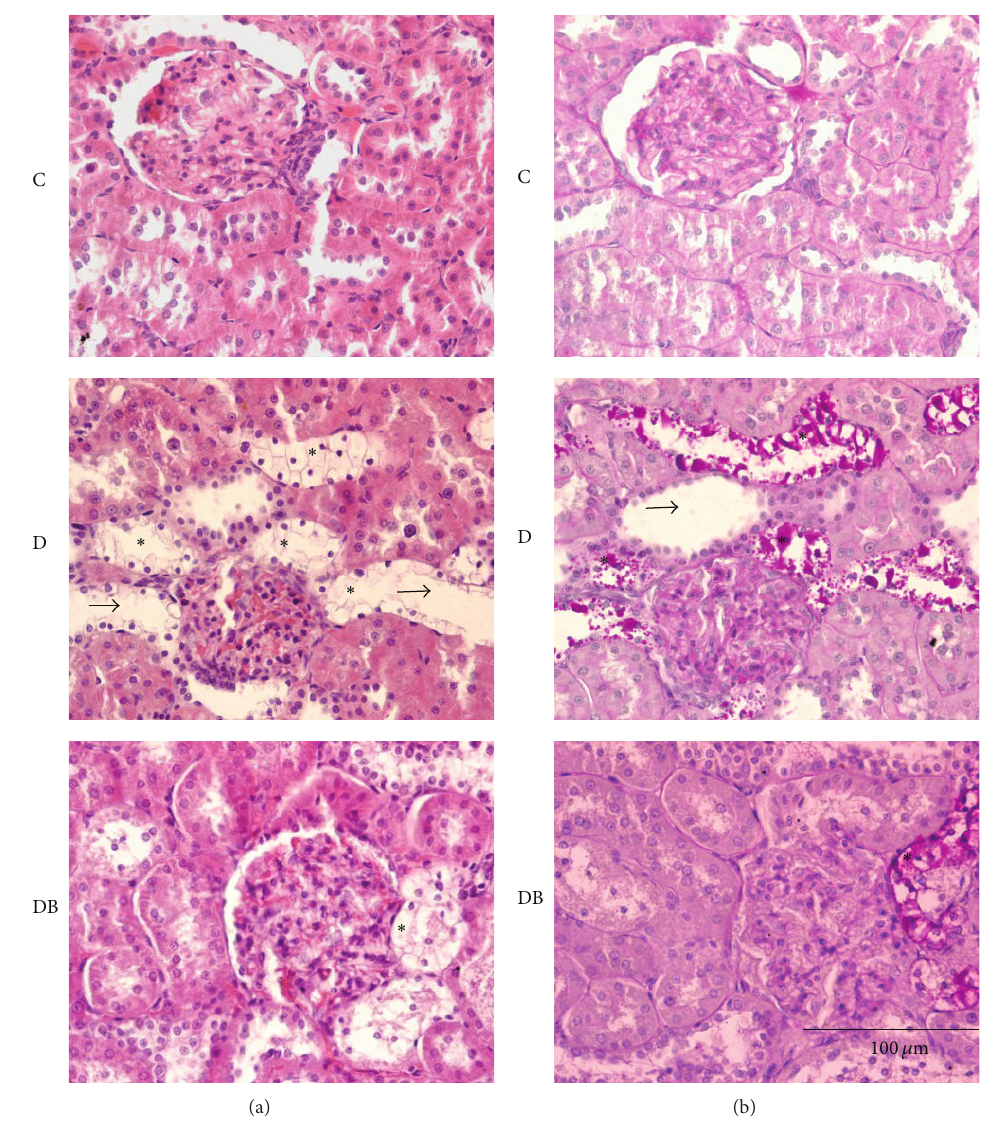
Figure 2: Boldine prevents the structural alterations in kidneys from diabetic rats. Serial kidney sections (5 𝜇 m) were either stained with (a) hematoxylin and eosin or (b) with PAS staining. The top panels correspond to kidney sections from control rats (C), the middle panels are fromdiabeticrats(D),andthebottompanelsarefromdiabeticratstreatedwith50 mg/Kg/dayboldine(DB). ∗ :indicateclearcells;arrowheads indicate dilated tubules. Note close spatial correspondence between clear cells and PAS staining. Each picture is representative of at least 5 different